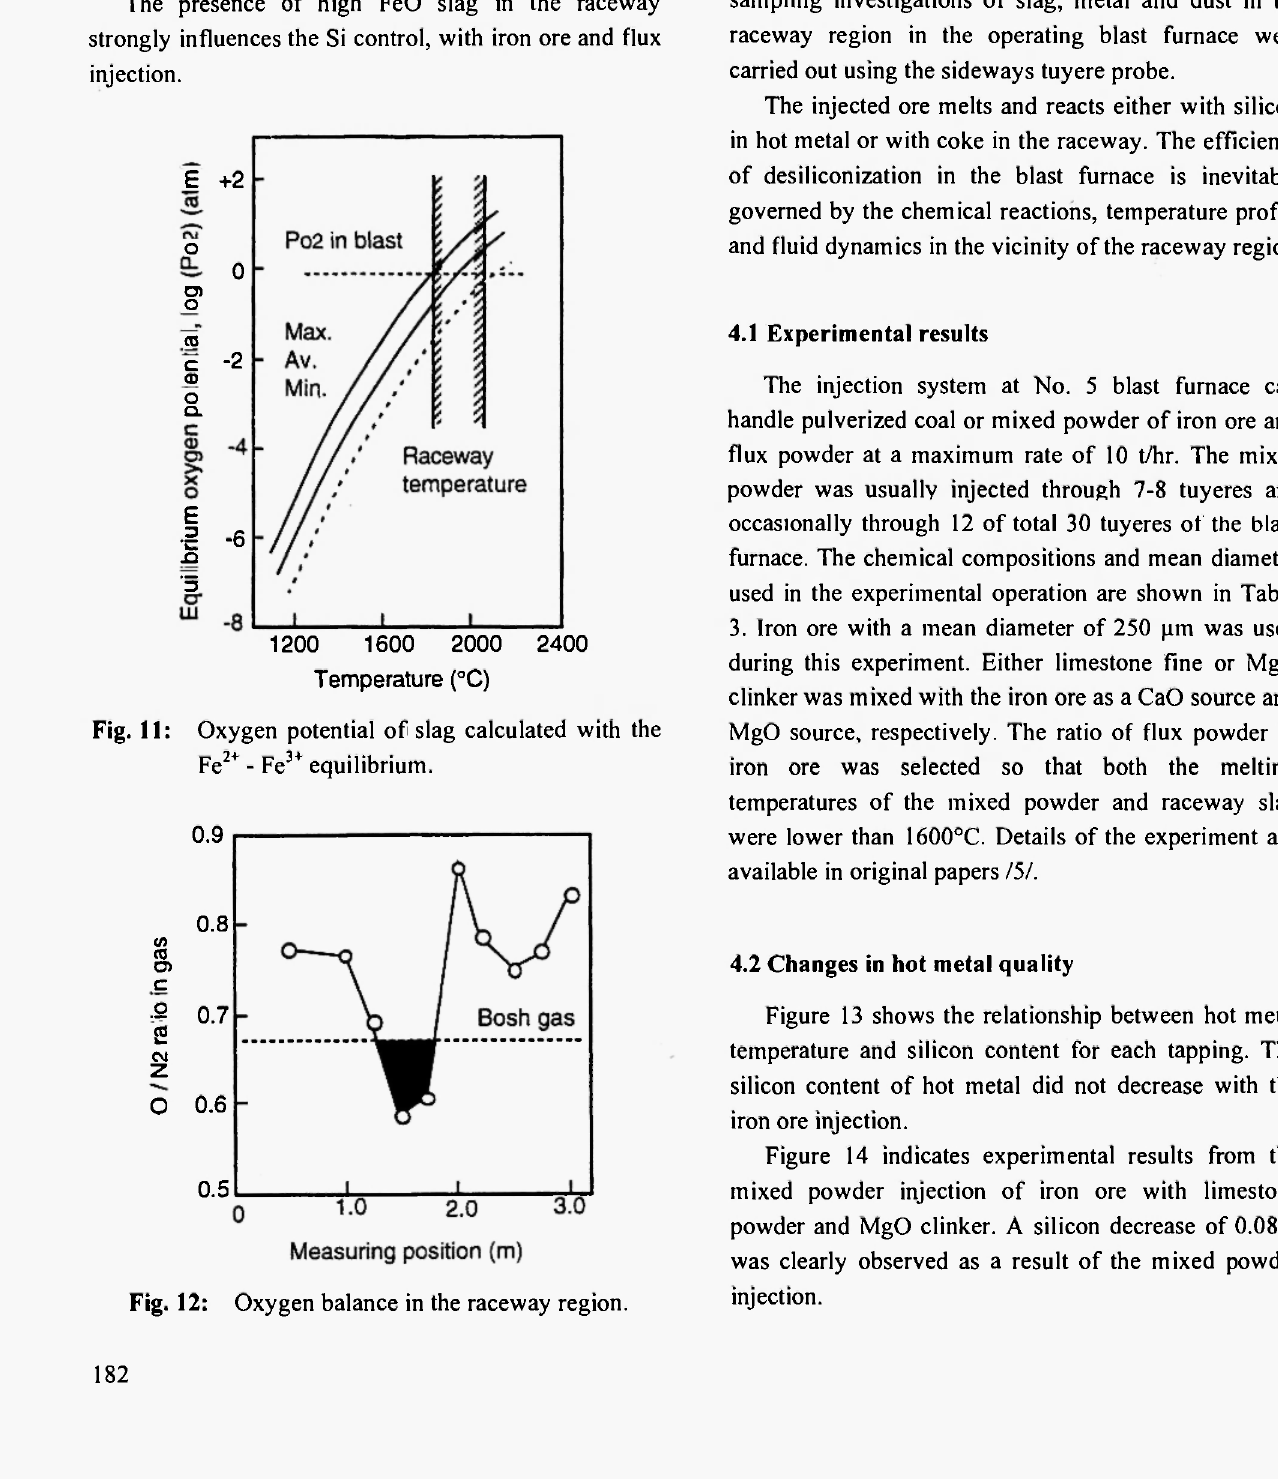
Fig. 11: Oxygen potential of slag calculated with the Fe 2+ - Fe 3+ equilibrium.